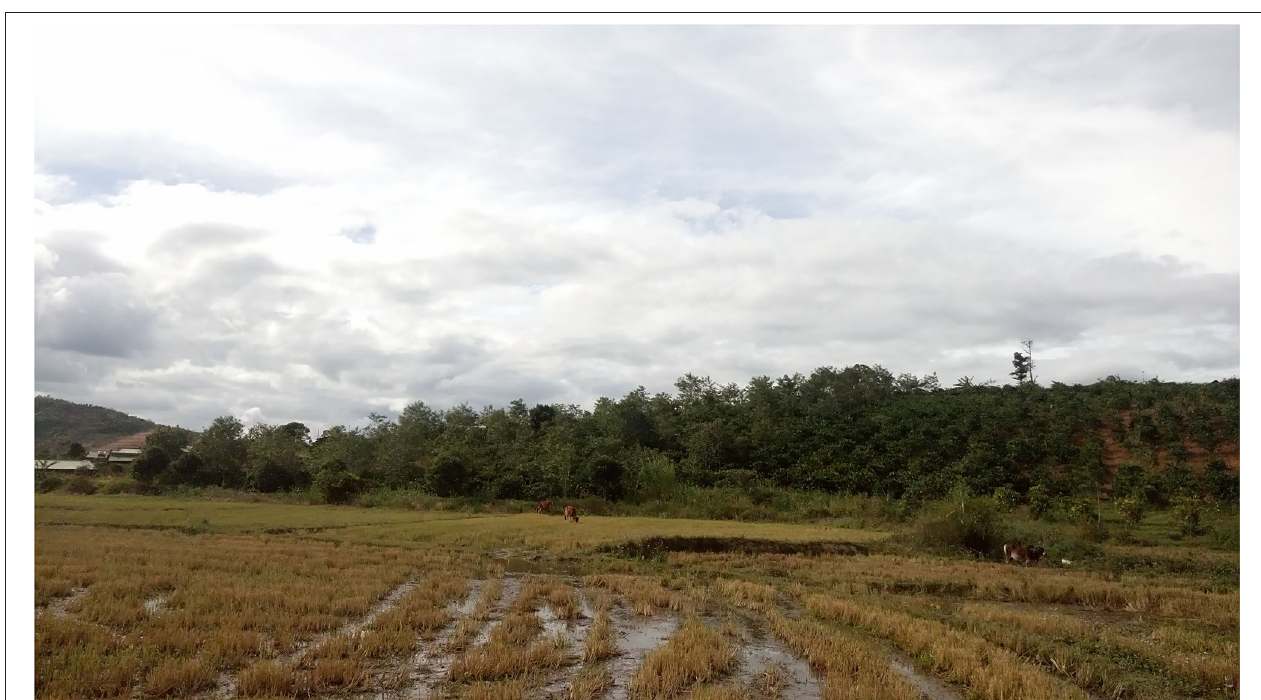
FIGURE 3 | Shade farm and sun farm A. Source: Photo provided by the owner of the shade farm. Shade farm covered with Senna siamea trees is on the left. Sun farm A is on the right.